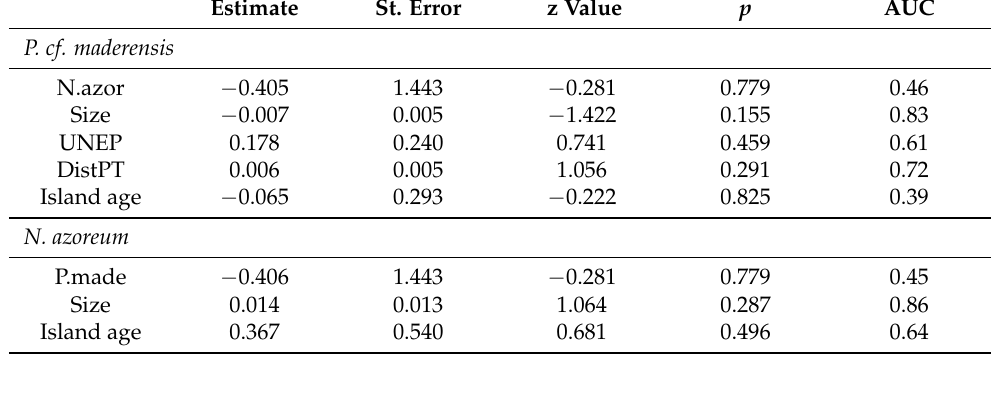
Table 1. Parameters of the univariate GLM models relating bat occurrence and island characteristics. All variables are described in Table A1. The area under the ROC curve (AUC) is presented as a measure of adjustment of each model. The full models, including the intercept, are available, see